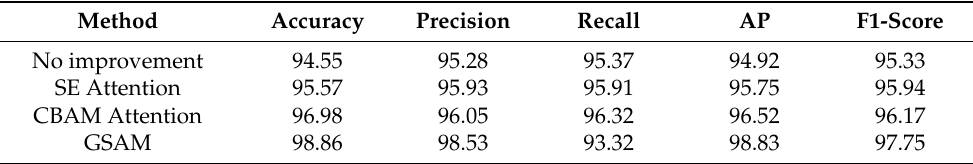
Table 6. Performance of the GSAM. The analysis results show that F = 3.431 > F crit = 3.238, reject H 0